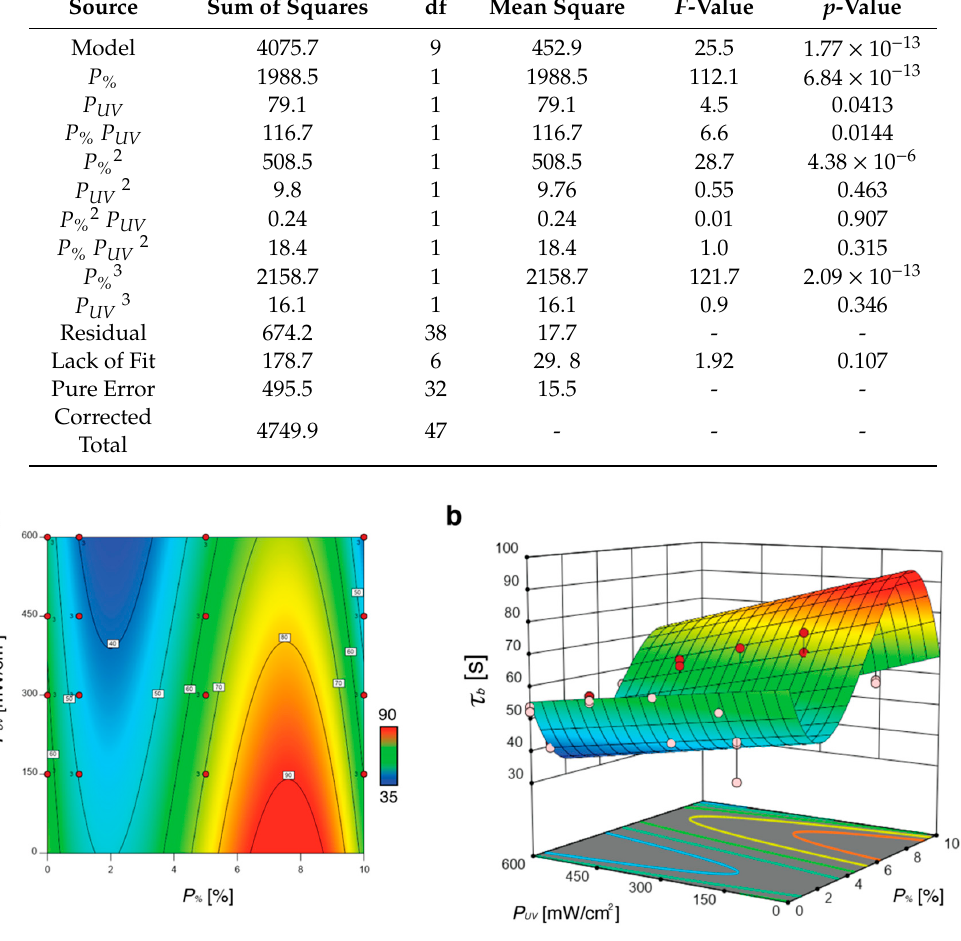
Figure 5. The value τ b in the photo-bending process, drawn by the reduced cubic model. ( a ) Contour plot in 2D and ( b ) surface plot in 3D. The dots represent the experimental data (i.e., the fit of the exponential model). The cubic model gives satisfying fit with these experimental data.